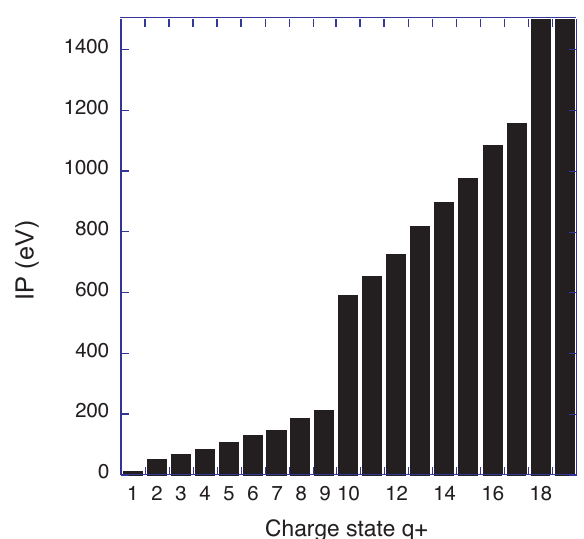
Figure 1. Ionization potentials of various Ca ions ([5] and others). The much higher values for one- and two-electron ions have been